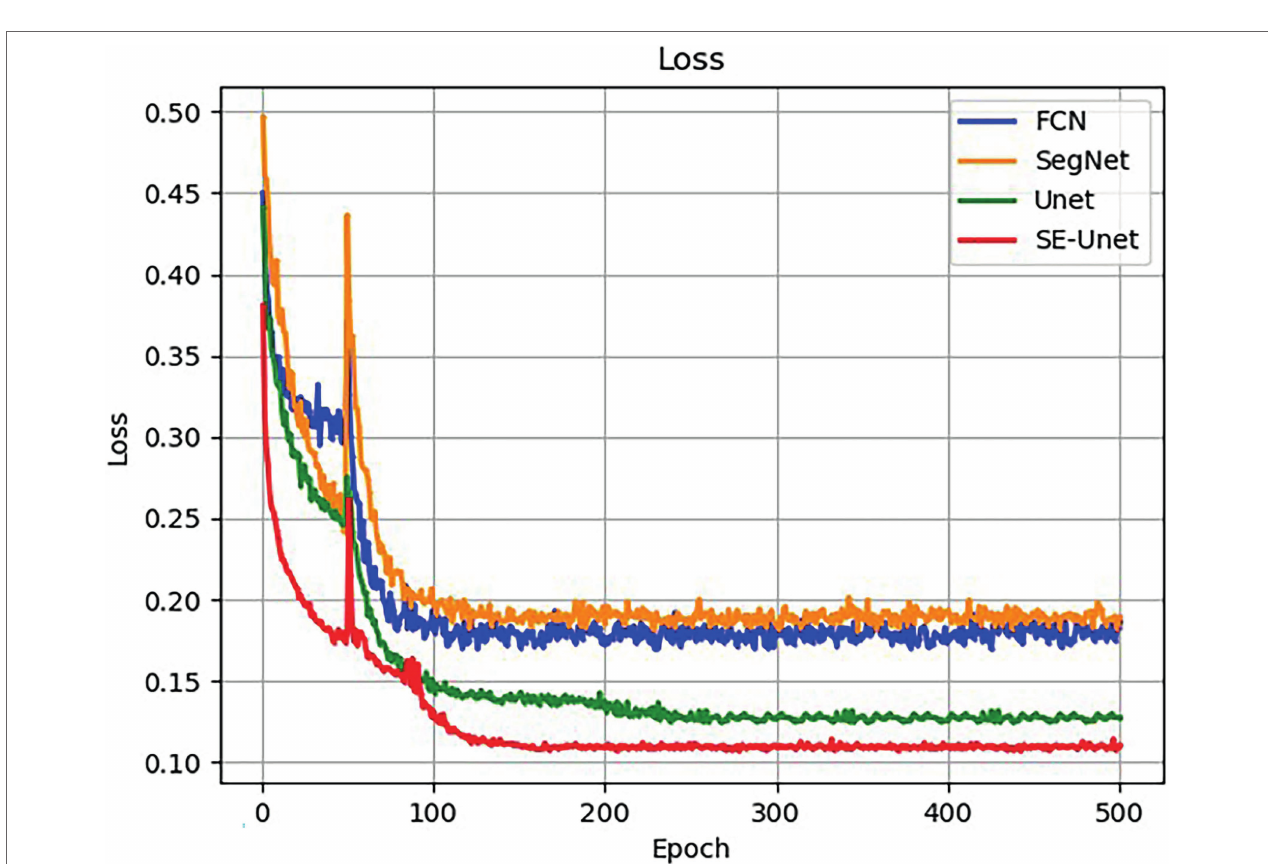
FIGURE 10 | Training loss of the different